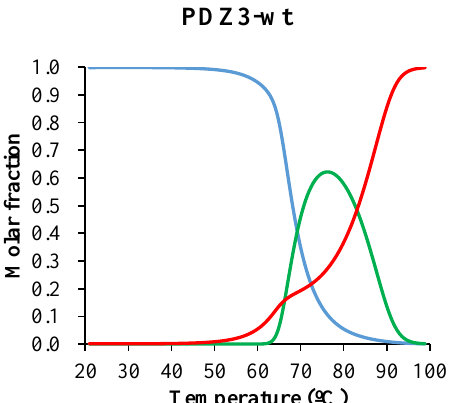
Figure 4. Molar fraction of PDZ3-F340A/E310L (N-D), F340A/N326L (N-I 4 -D), F340A/R309L (N-D), PDZ3-F340A (N-D model) and PDZ3-wt (N-I 5 -D model) by DDCL3 analysis of DSC thermograms at 1 mg/mL, pH 7.5, and 1 °C/min scan rate. The lines represent natively folded monomers (blue), intermediate oligomers (green), and unfolded monomers (red).